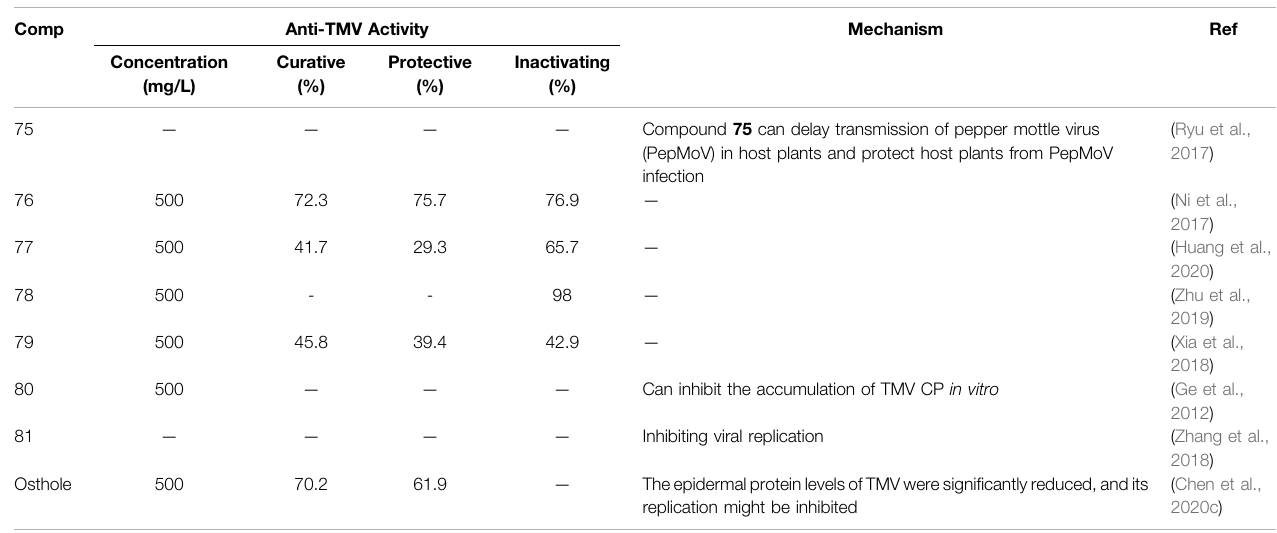
TABLE 3 | Antiviral activity of other representative ester or lactone